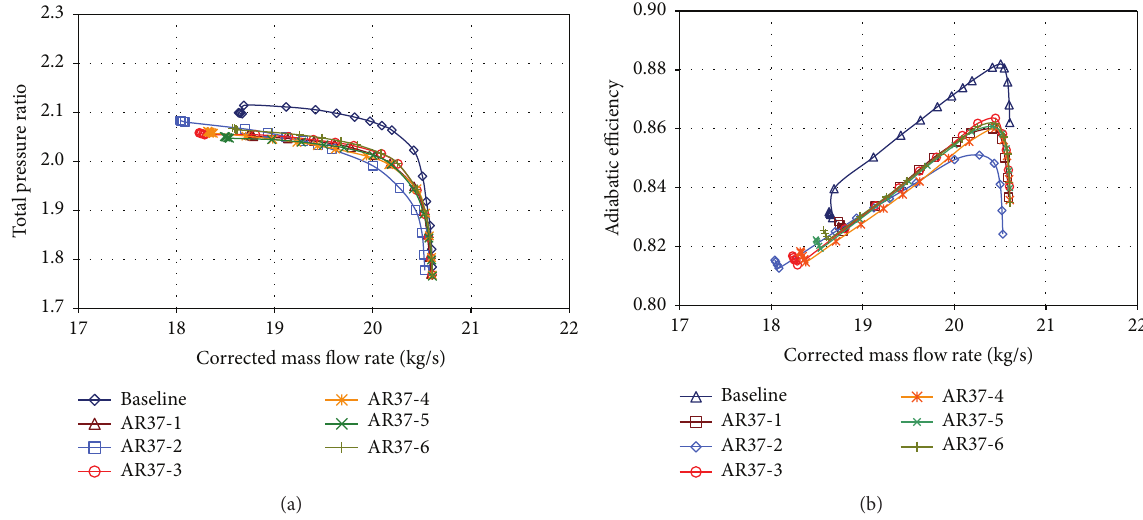
Figure 13: Predicted performance characteristics of compressor rotor for different aspiration slot configurations (100% design rotational speed).